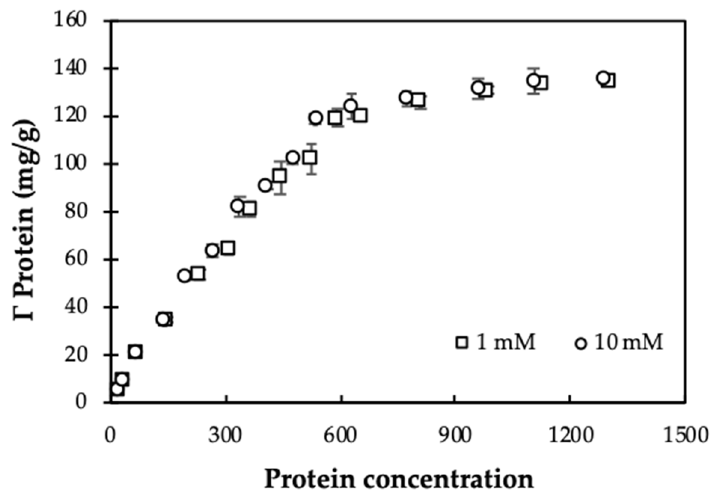
Figure 6. Adsorption isotherms of Moringa (MO) seeds protein onto nanosilica at different KCl concentrations (pH 10). Error bars show standard deviations of three replicates.